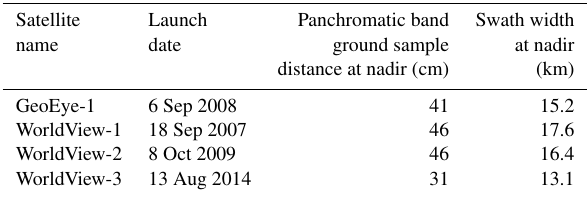
Table 1. Specifications of satellites and imagery used in